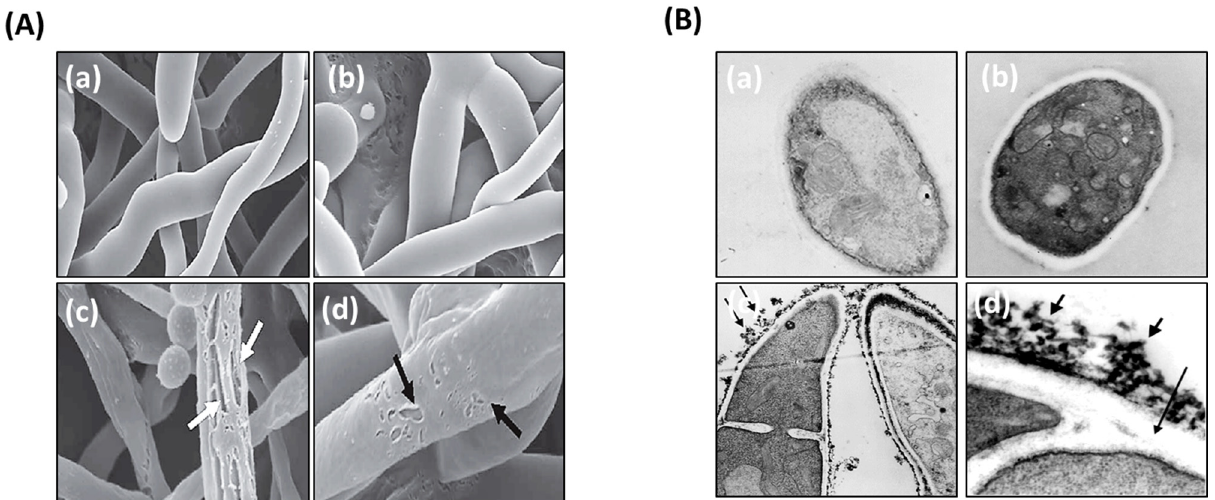
Figure 4. Electron microscopy photographs of A. fumigatus after treatment with LH-AuNPs. ( A ) SEM images of A. fumigatus treated with saline ( a , b ) and LH-AuNPs ( c , d ) (64 µg/mL). Black arrows specify pitting and tearing destruction to the cell wall. White arrows show penetration of cell wall into the cytoplasm. Bar = 5 µm. ( B ) TEM images of A. fumigatus treated with saline ( a , b ) showing normal growth of A. fumigatus hyphae and treated with LH-AuNPs ( c , d ) showing reticular accumulations on the cell wall on the outer fibrillar layer (arrows) ( c ) and the outer fibrillar layer has a lattice-like structure that is thready (thick arrows). The inner fibrillar layer is not consistently observable (thin arrow) ( d ).